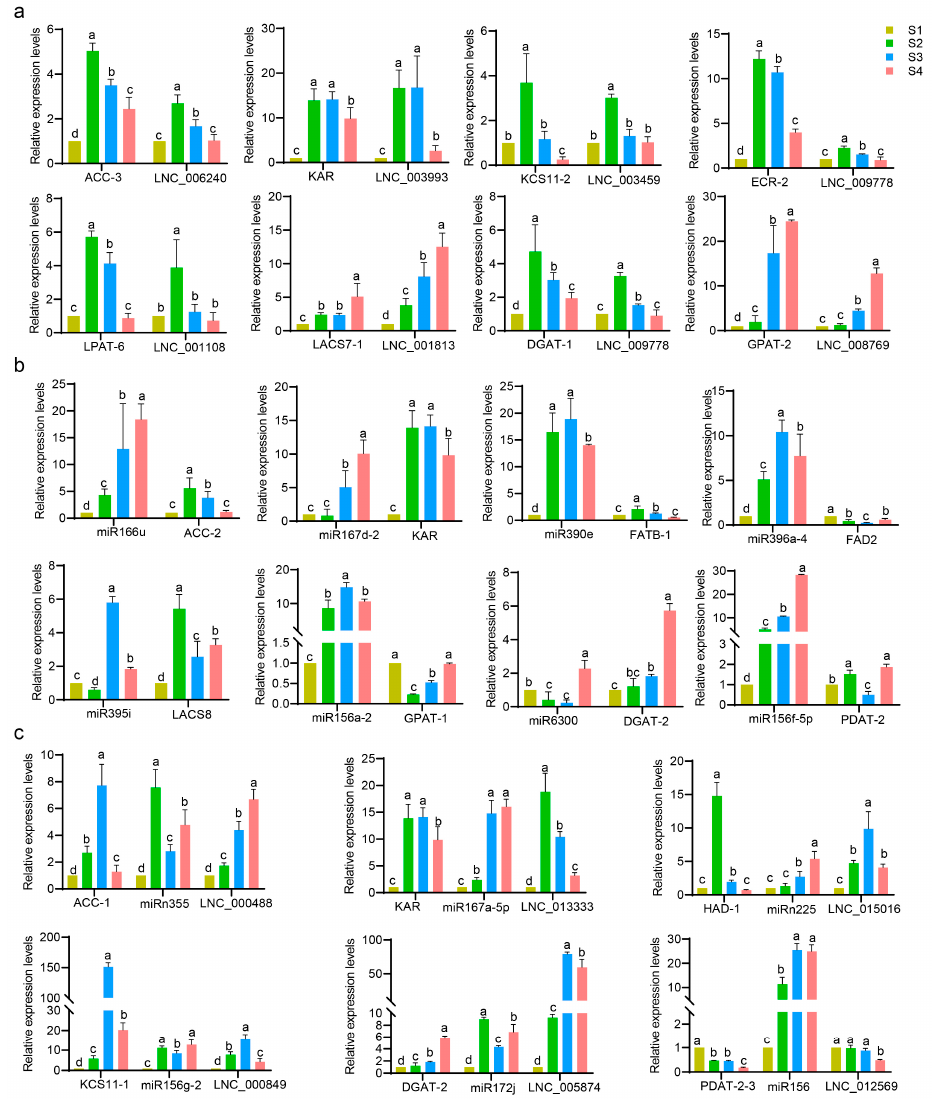
Figure 12. Expression patterns of the selected lncRNA–mRNA pairs, miRNA–mRNA pairs, and lncRNA–miRNA–mRNA modules in the context of the FA and TAG biosynthesis pathways. The gene pairs in the upper half of ( a , b ) are involved in FA biosynthesis pathways, the lower half of ( a , b ) are pairs involved in TAG biosynthesis pathways. In ( c ), the ACC-1 –miRn355–LNC_000488, KAR–miR167a-5p–LNC_013333, HAD-1 –miRn225–LNC_015016, and KCS11-1 –miR156g-2–LNC_000849 modules were suggested to be relevant to FA biosynthesis pathways, and DGAT-2 –miR172j–LNC_005874 and PDAT-2-3 –miR156–LNC_012569 were suggested to be relevant to TAG biosynthesis pathways. Data from qPCR experiments were analyzed using Duncan’s multiple range test. Significant differences ( p -value < 0.05) are indicated by different lowercase letters.